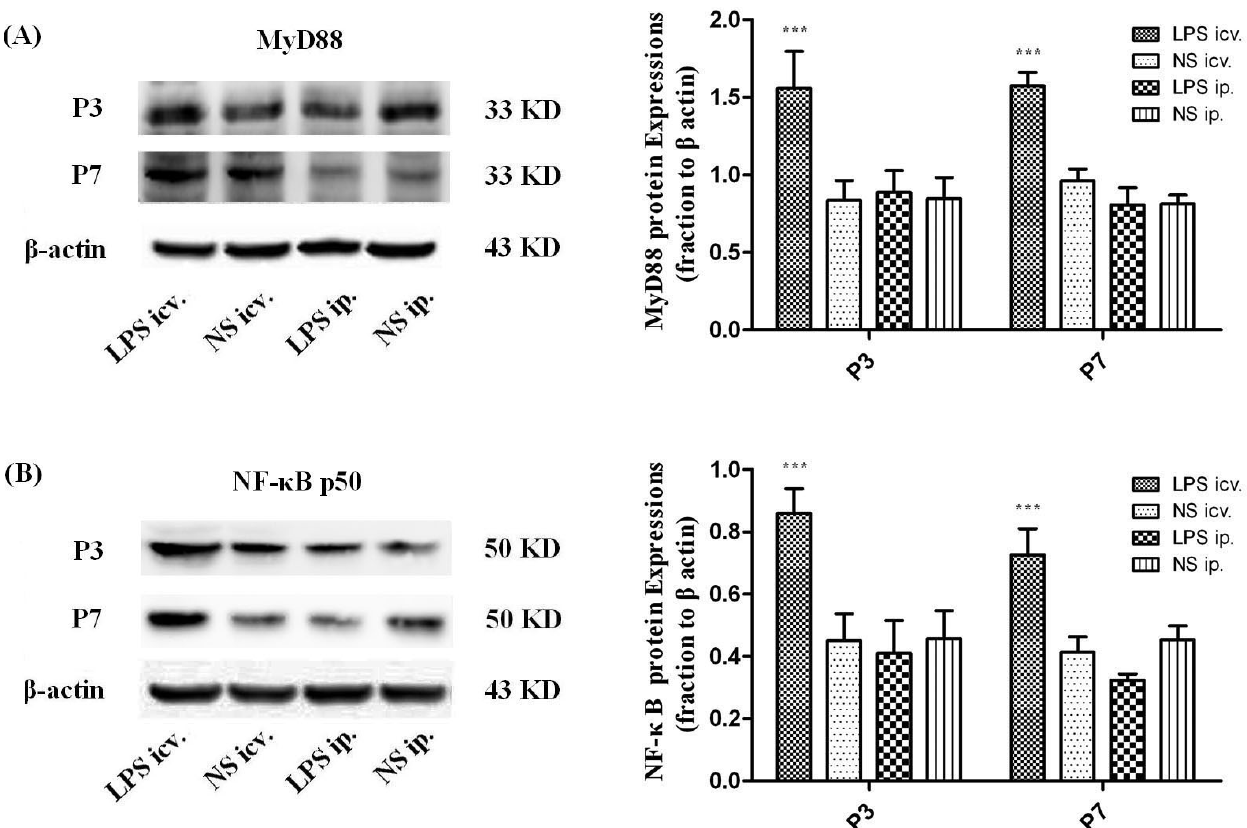
Figure 6. The protein levels of MyD88 and NF- κ B p50 in the neonatal rat (P3 and P7) brains 12 h after icv. or ip. injection of LPS or NS. ( A ) Representative picture of the immunoblot of MyD88 in the neonatal rat brains treated with the central or peripheral LPS or NS, and the graph of statistical analysis of the immunoblot of MyD88 in the brain in various groups. *** p < 0.001, compared with the central NS injection; ( B ) Representative picture of the immunoblot of NF- κ B p50 in the neonatal rat brain treated with the central or peripheral LPS or NS, and the graph of statistical analysis of the immunoblot of NF- κ B p50 in the brain in various groups. *** p < 0.001, compared with the central NS